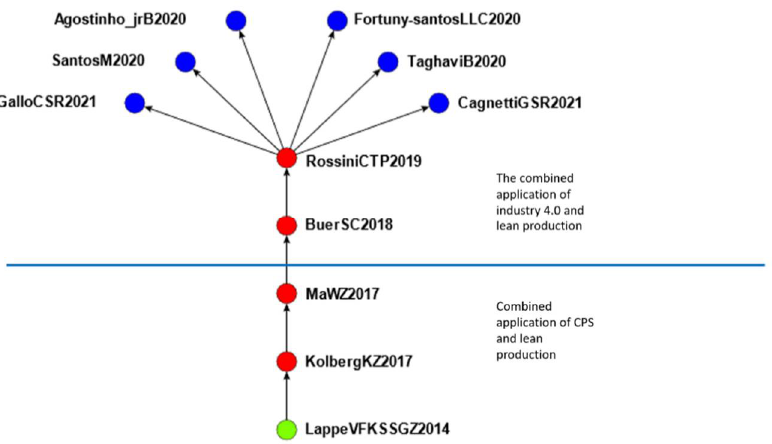
Figure 8. The main path of the third group.